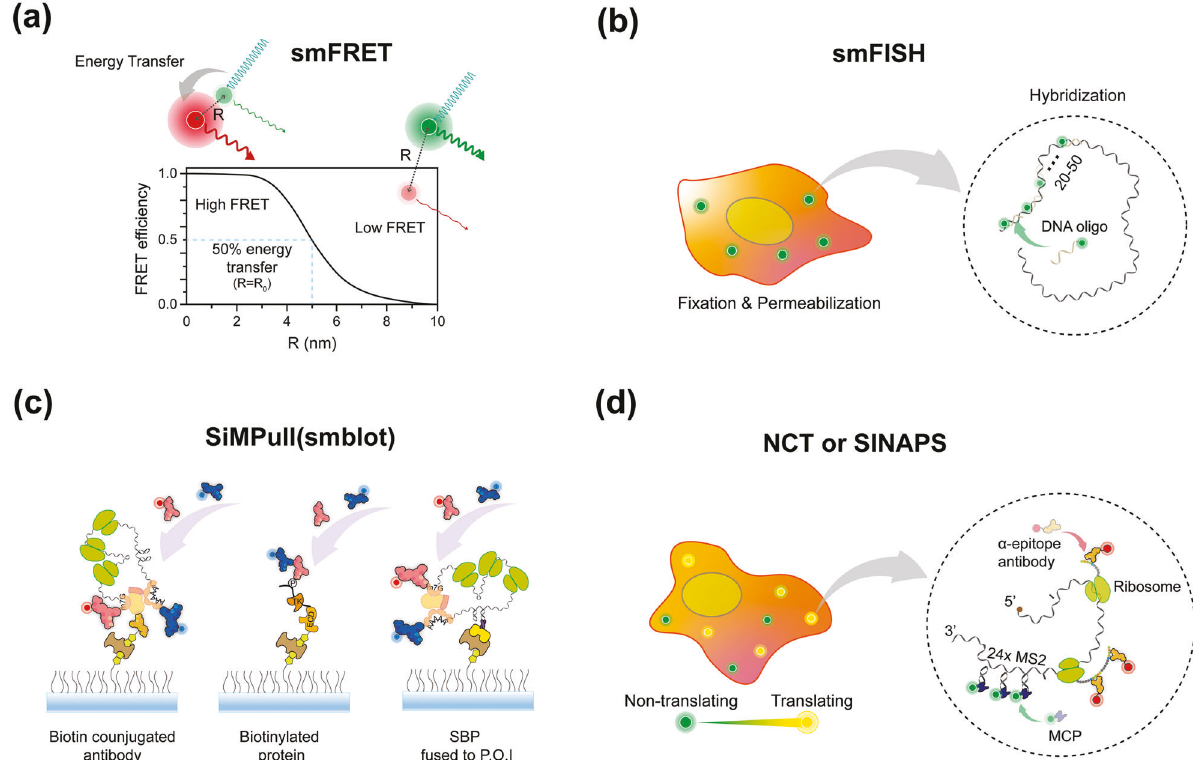
Fig. 1 SmFI techniques applied to an mRNA circularization study. a The relationship between FRET ef fi ciency and interdye distance. When the interdistance R between the donor (green) and acceptor (red) is within 10 nm, the excited energy of the donor is transferred to the acceptor, which subsequently emits fl uorescence. The FRET ef fi ciency is inversely proportional to the interdye distance, and 50% of the energy is transferred when R is equal to R 0 . b Principle of smFISH. Cells are fi xed and permeabilized for introducing the probes ( fl uorescently labeled DNA oligonucleotides with ~20 nt, which is a suf fi cient length for stable hybridization with RNA at room temperature). Typically, 20 – 50 probes are used for signal ampli fi cation. c Schematic showing the mRNP complex or EGFR immobilized on a PEG-biotin surface via either a biotin- conjugated antibody, biotinylated protein, or SBP fused to the protein of interest. A fl uorescently labeled antibody is introduced that binds to the target. The heterogeneous state of a single mRNP or EGFR is investigated quantitatively, including the number or combination of constituents. d Nontranslating (green) or translating (yellow) mRNAs in a cell. As the ribosome synthesizes the epitopes in a coding sequence, the fl uorescently labeled antibody (red) binds to the nascent epitope, and the fl uorescence intensity depends on the number of nascent epitopes. Fluorescently labeled MCP binds to the MS2 stem ‒ loop in the 3 ʹ -UTR, irrespective of the translational state, and indicates the location of the and detected using fl uorescently labeled antibodies. A fl uores- cence signal indicates whether a speci fi c component is contained in a target. When SiMPull is conducted with multicolor imaging, the combination of fl uorescence signals provides the quantitative ratio of components.